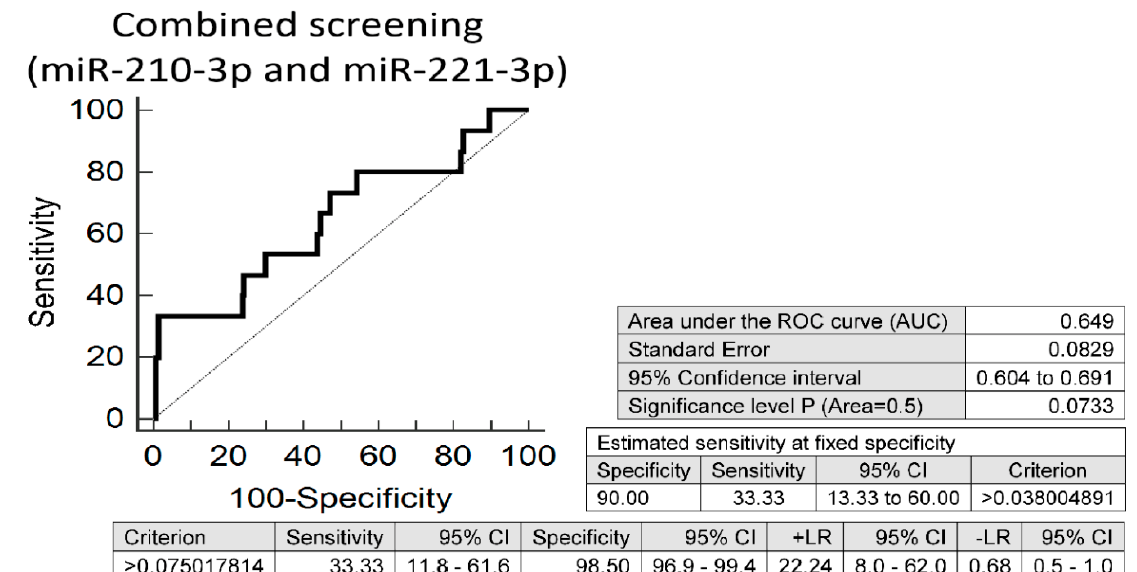
Figure 3. Aberrant microRNA expression profile in mothers on blood pressure treatment. Irrespective of the course of gestation (normal and complicated pregnancies altogether), screening based on combination of miR-210-3p and miR-221-3p showed the best performance from various microRNA combinations. At 10.0% FPR 33.33% mothers on blood pressure treatment had substantially altered expression profile of miR-210-3p and miR-221-3p.